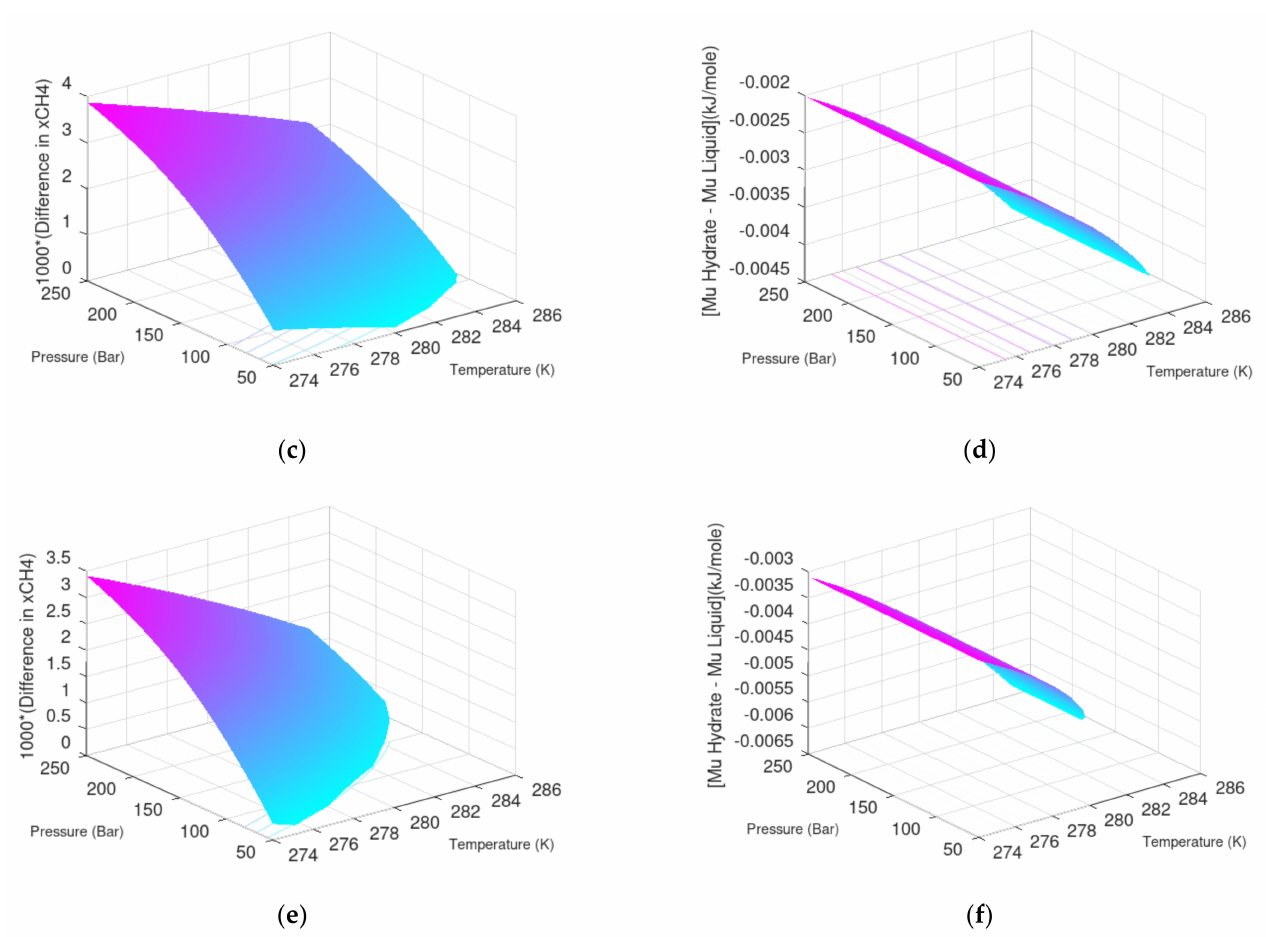
Figure 8. Difference between mole-fraction for CH 4 solubility and mole-fraction for minimum hydrate stability ( a , c , e ) as function of temperature and pressure and difference in water chemical potential between hydrate and liquid ( b , d , f ). ( a , b ) are for pure water, ( c , d ) are for water with mole-fraction NaCl 0.0108, and ( e , f ) are for water with mole-fraction NaCl